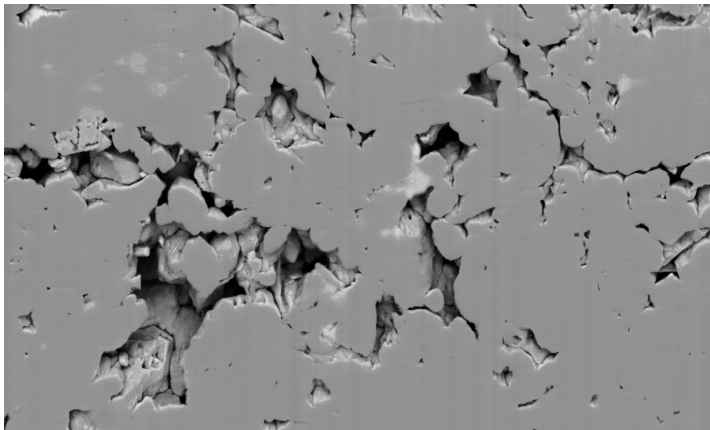
Figure 15. A slice of an FIB-SEM image of a sample of carbonate rock. Because pore-back effect segmentation of FIB-SEM images is a challenging problem, several approaches based on marker-controlled watershed were proposed to solve it